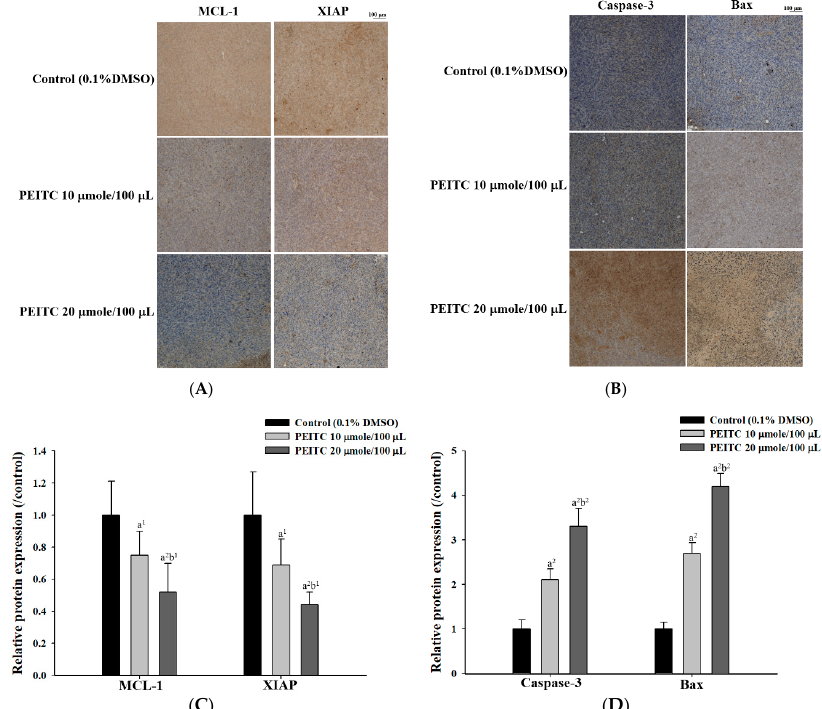
Figure 3. The effects of PEITC on the expressions of apoptosis-associated proteins in xenograft GBM 8401/ luc2 cells-bearing mice. Tumors were isolated from xenograft GBM 8401/ luc2 cells-bearing mice after treatment. All samples were analyzed under microscopy at ×100 magnification and photographed. ( A ) MCL-1 (myeloid cell leukemia 1) and XIAP (X-linked inhibitor of apoptosis protein); ( B ) Caspase-3 and Bax. ( C ) Quantification results of MCL-1 and XIAP. ( D ) Quantification results of Caspase-3 and Bax. a 1 : p < 0.05, a 2 : p < 0.01 compared to that of the control; b 1 : p < 0.05, b 2 : p < 0.01 compared to that of PEITC-10 group.